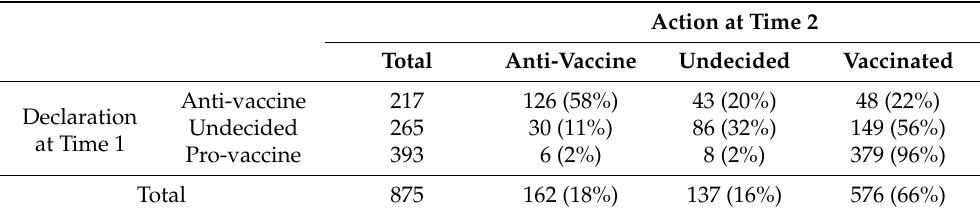
Table 1. Comparison between declared vaccination intent at Time 1 and action at Time